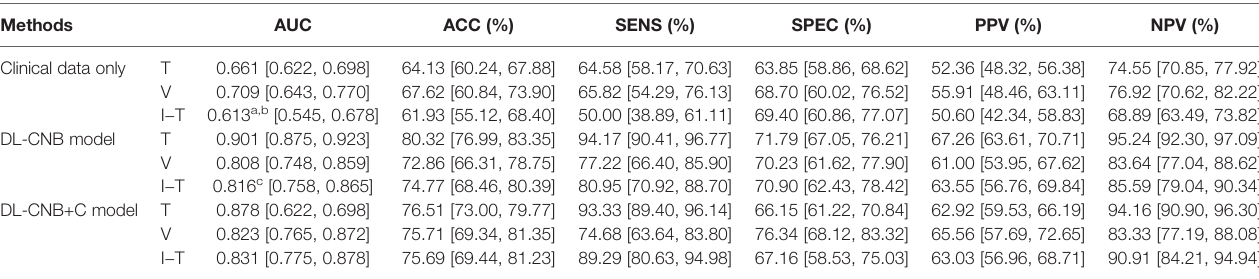
95% con fi dence intervals are included in brackets. AUC, area under the receiver operating characteristic curve; ACC, accuracy; SENS, sensitivity; SPEC, speci fi city; PPV, positive predictive value; NPV, negative predictive value; T, training cohort (n = 630); V, validation cohort (n = 210); I – T, independent test cohort (n = 218); ALN, axillary lymph node; DL-CNB+C, deep learning core-needle biopsy incorporating the clinical data. a Indicates p < 0.0001, Delong et al. in comparison with DL-CNB model in independent test cohort. b Indicates p < 0.0001, Delong et al. in comparison with DL-CNB+C model in independent test cohort. c Indicates p = 0.4532, Delong et al. in comparison with DL-CNB+C model in independent test cohort.